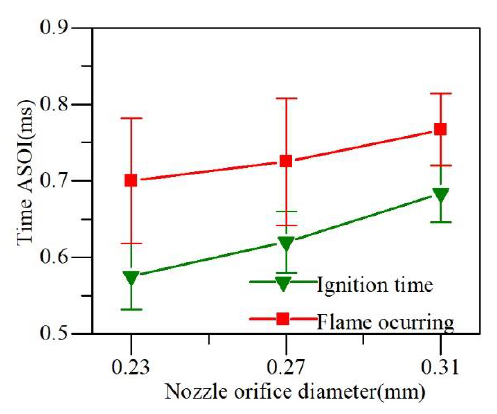
Figure 11. Ignition delay and flame occurring time.